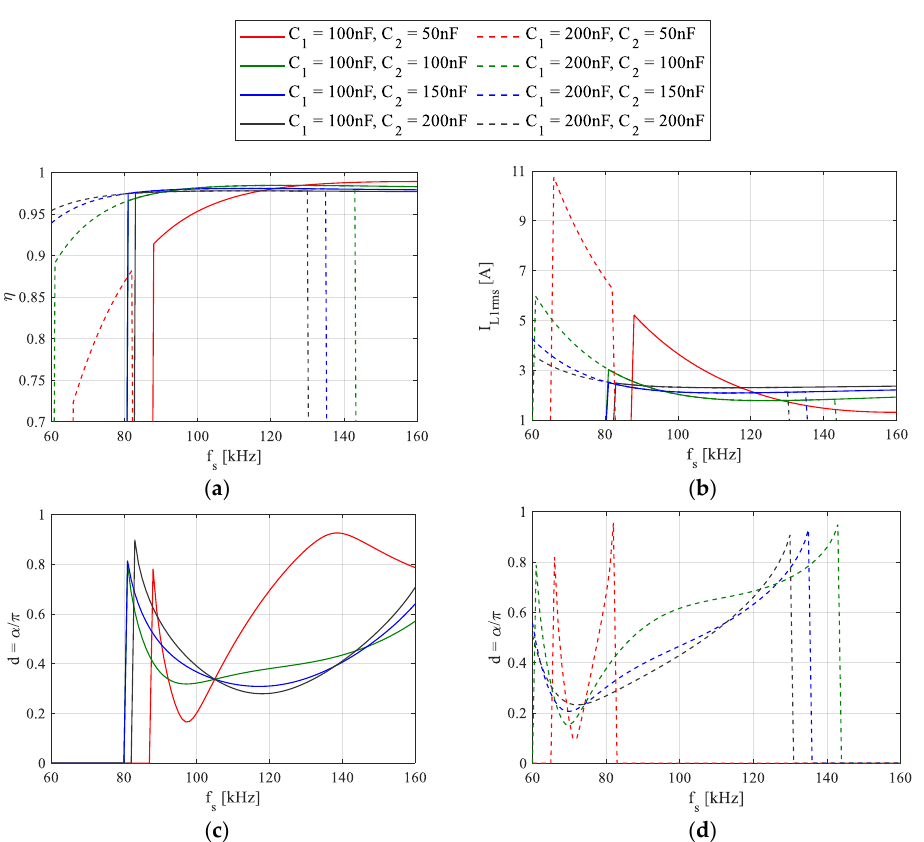
Figure 11. Predictions of IPTS modeling solution (5) – (8) vs. f s , for different values of C 1 and C 2 : ( a ) IPTS efficiency η ; ( b ) primary coil rms current I L 1rms ; ( c ) normalized phase-shift d for C 1 = 100 nF; ( d ) normalized phase-shift d for C 1 = 200 nF.